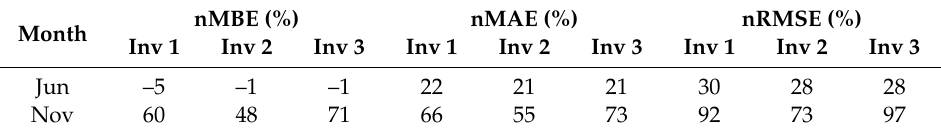
Table 2. Normalized mean bias error (nMBE), normalized mean absolute error (nMAE), and normalized root mean squared error (nRMSE) by inverter, for June and November